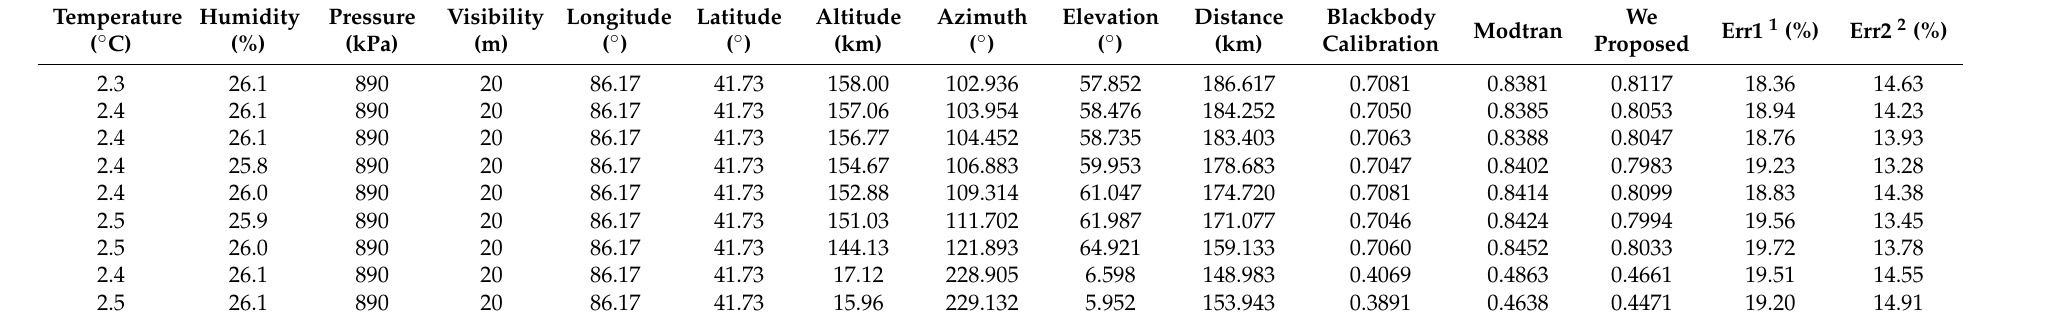
Table 3. Comparison of the DNN-based prediction method and software prediction with Modtran for atmospheric transmittance.